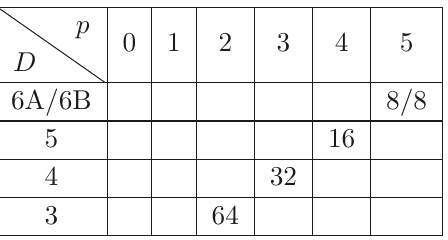
Table 11 . The F 10 , 1 , 1 (IIA) or F 10 (IIB) family of branes for the ( T 4 / Z 2 ) × T n theories. Here